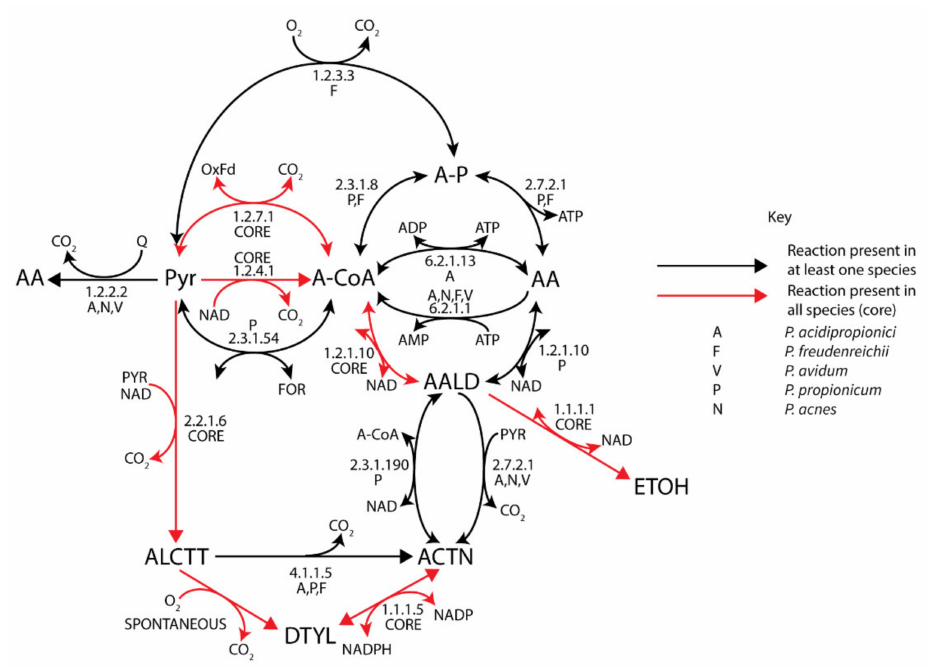
Figure 3. Acetate, acetoin, and ethanol metabolism of Propionibacterium . (Black) arrows represent reactions present in at least one species. (Red) arrows represent reaction in all species